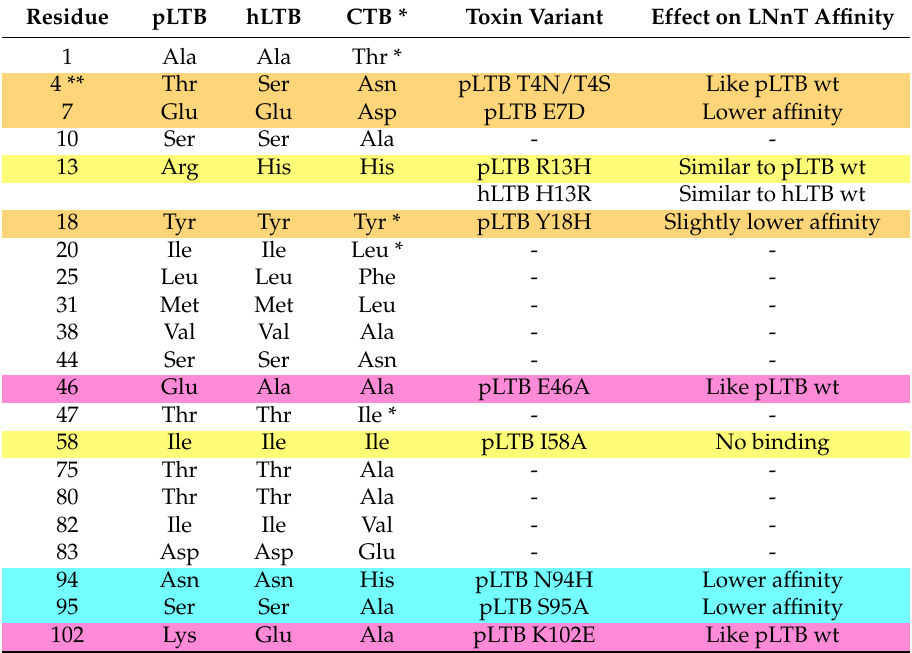
Table 2. Sequence and affinity differences between pLTB, hLTB, CTB, and toxin